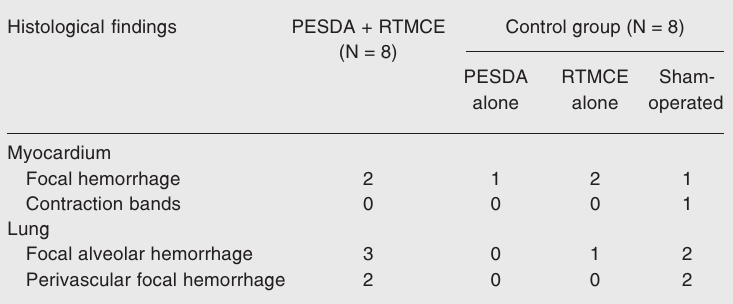
Perivascular focal hemorrhage 2 0 0 2 Data are reported as number of